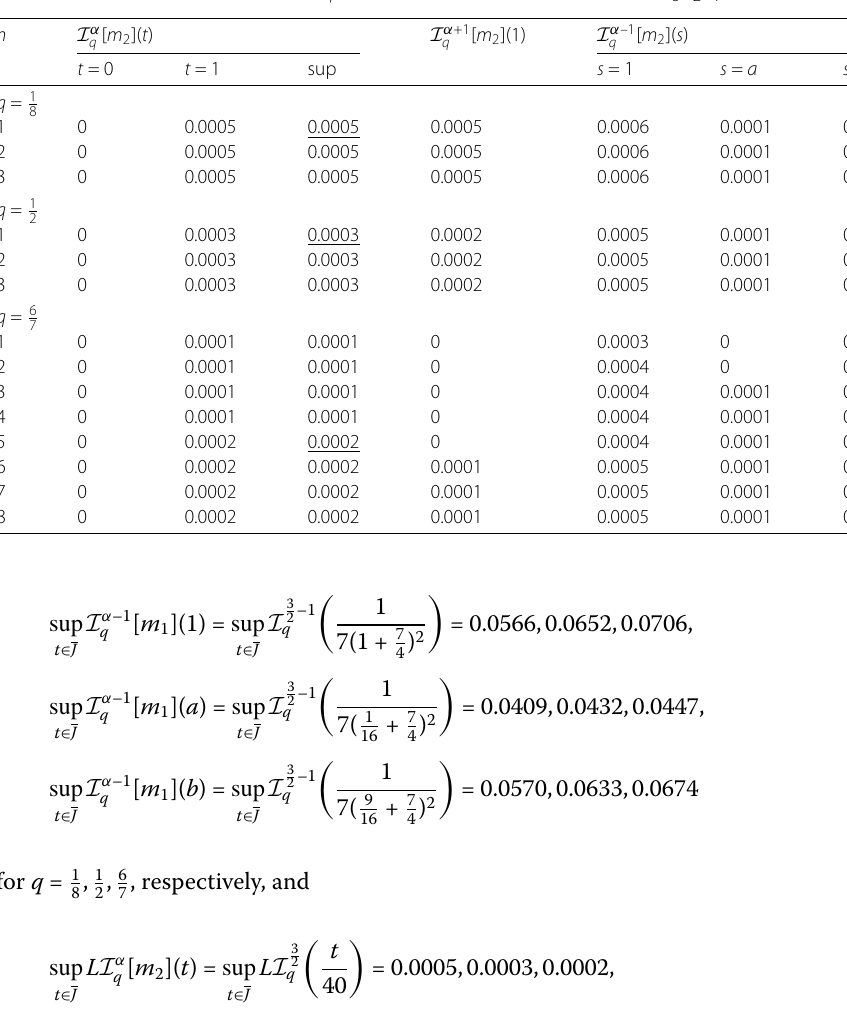
Table 5 Some numerical results of I α q [ m 2 ]( t ) in Example 1 for t ∈ J and q = 1